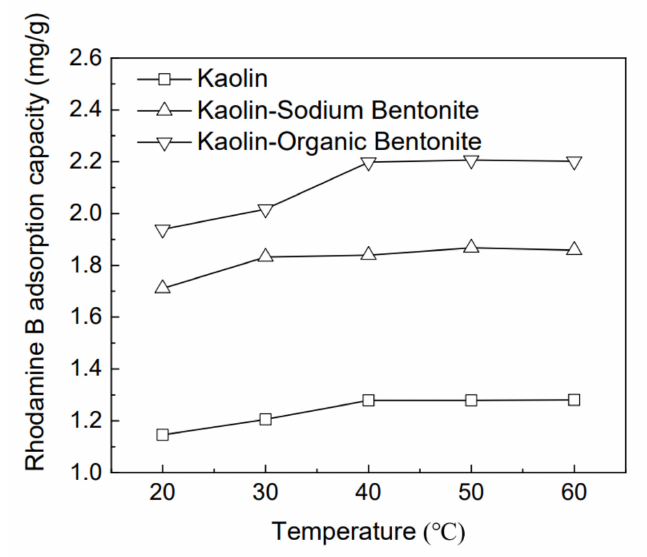
Figure 6. Effect of temperature on the removal of rhodamine B by different